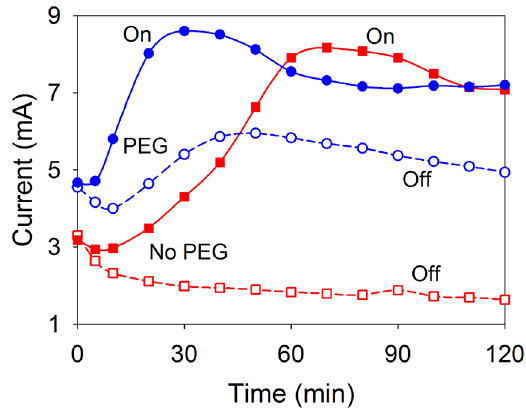
Figure 10. Ln(C/C0) vs. Time ( ● ) experimental data, and (‑‑‑) linear fit. The kinetic constant was derived from the slope of the linear fit to the experimental data.